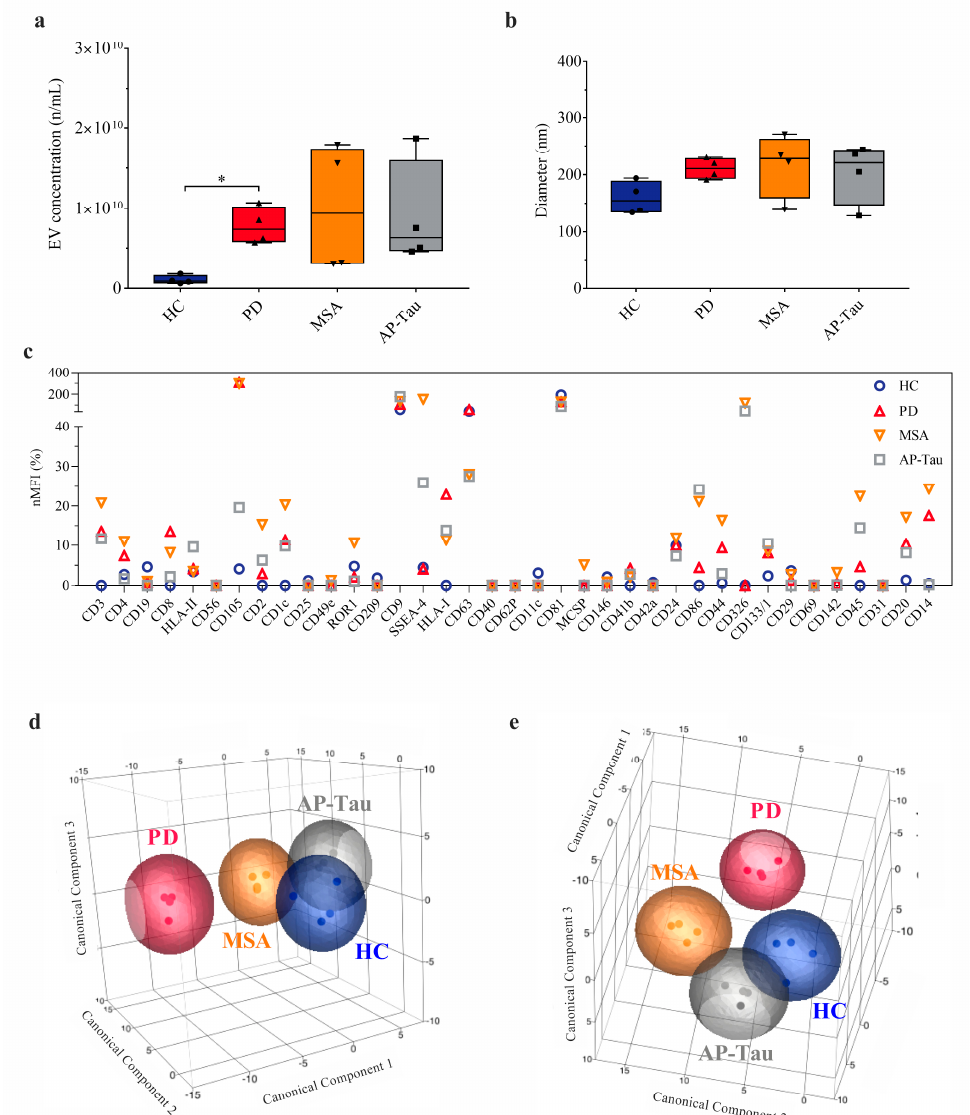
Figure 3. CSF-derived EVs characterization. Characterization of cerebrospinal fluid (CSF)-derived extracellular vesicles (EVs) by nanoparticle tracking analysis (NTA) and MACSPlex human exosome assay flow cytometry. Healthy controls (HC) were compared with patients with Parkinson’s disease (PD) multisystem atrophy (MSA), or atypical parkinsonism with tauopathies (AP-Tau). ( a ) EV concentration (n/mL CSF) at NTA. ( b ) EV diameter (nm) at NTA. Boxplots show median and interquartile range; bars show minimum and maximum values (* p < 0.05). ( c ) Normalized median fluorescence intensity (nMFI; %) for 37 EV surface markers. Data and statistics are reported in Table S1. ( d , e ) Different perspectives of 3D-canonical plot reporting patient discrimination according to EV surface marker expression (each patient is indicated by a point and diagnoses are represented by colors: HC, blue; PD, red; MSA, orange; AP-Tau, grey). Canonical axes of the plot (canonical components 1, 2, and 3) are defined by linear discrimination analysis from weighted linear combinations of the 37 EV markers analyzed by flow cytometry. Spheres include patients with linear combination coefficients that fall within the mean ± SD (canonicals 1, 2, and 3 ±